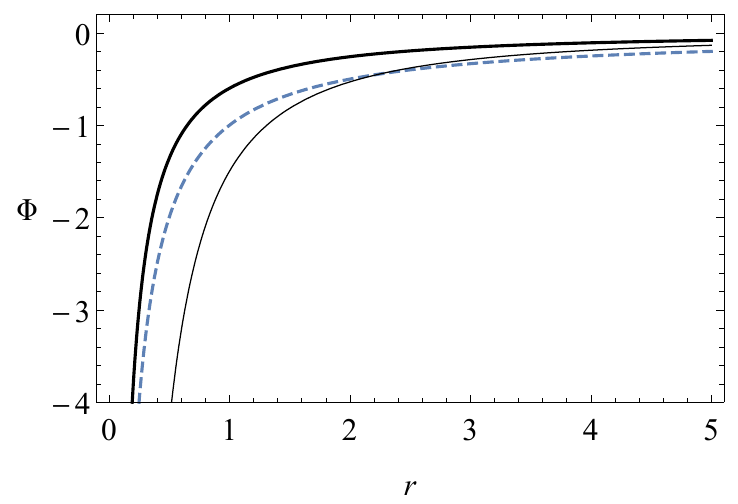
Figure 8 . Gravitational potential in d = 3 spatial dimensions for a point-wise source in the theory with q -derivatives with α > 1 ( α = 1 . 5 in this example), in the Einstein-theory limit (A.23) ( r (cid:28) r , dashed curve), in the fractional limit (5.17) ( r (cid:29) r ∗ expression (5.16) (solid thick curve). Here Gm = 1 and r